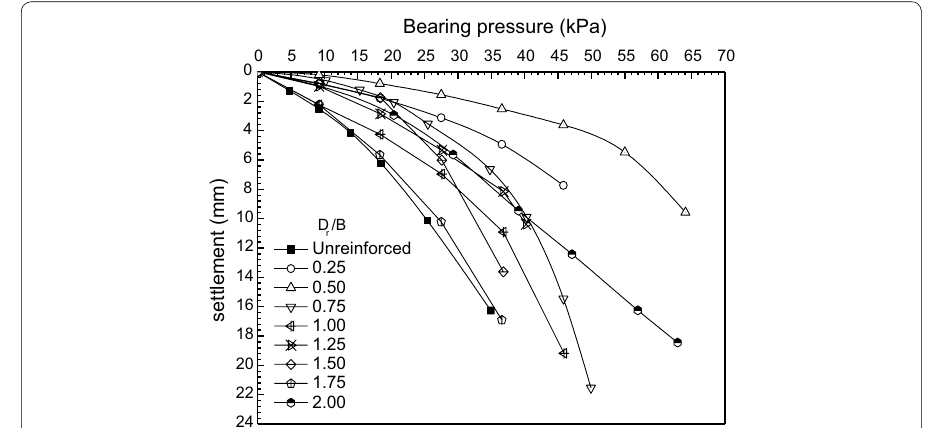
Fig. 3 Bearing pressure-settlement behavior of 50 mm square model footing on geojute reinforced